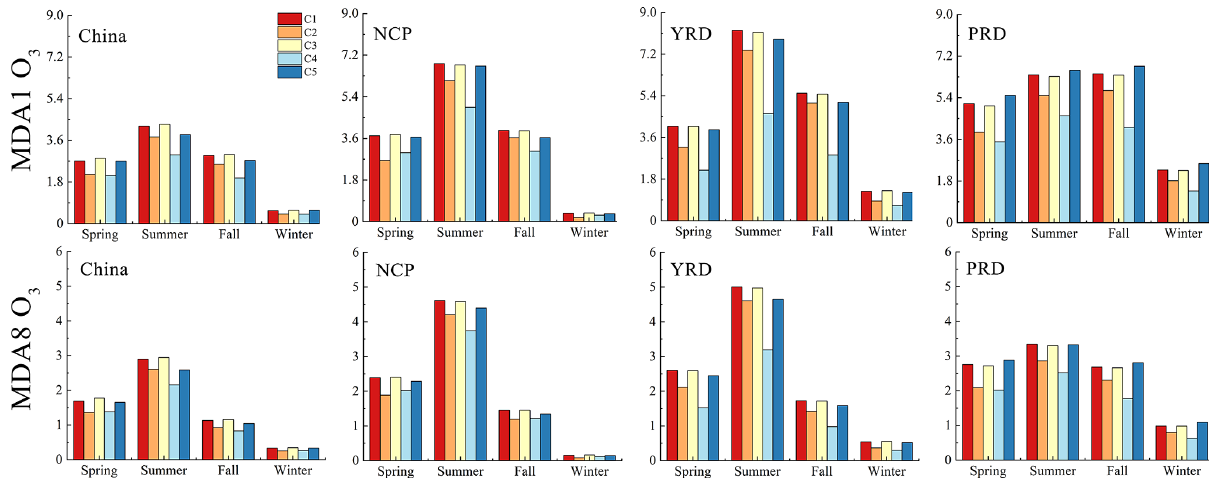
Figure 6. Seasonal-averaged concentrations of MDA1 O 3 and MDA8 O 3 from biogenic emissions in important regions and China.